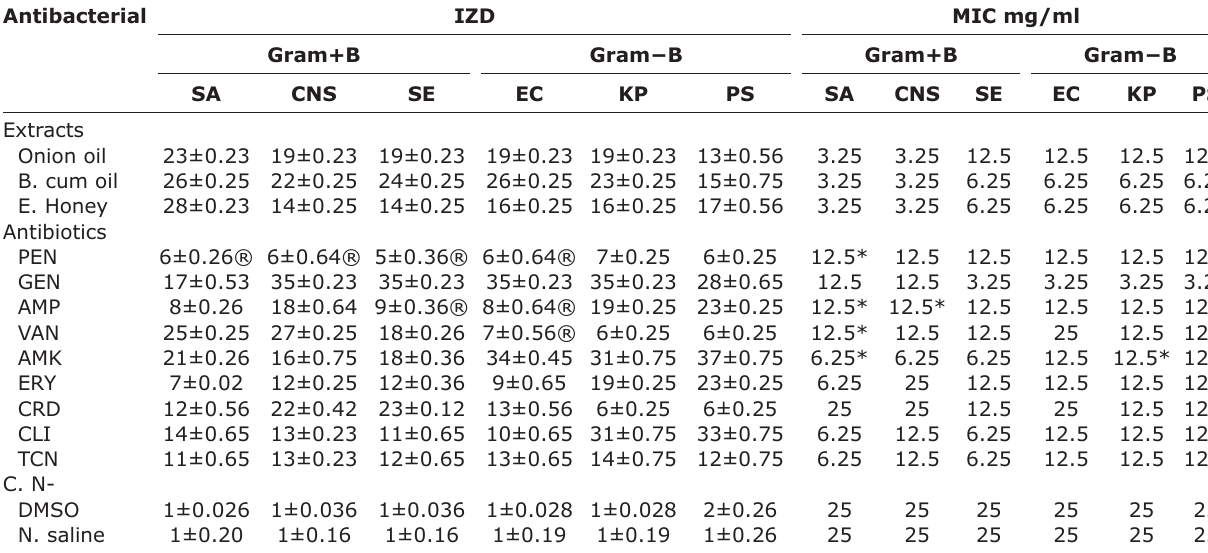
Table-3: Antibacterial effect of antibiotics and essential oils, plant extracts, and honey against bacteria isolated from clinical and subclinical mastitis.